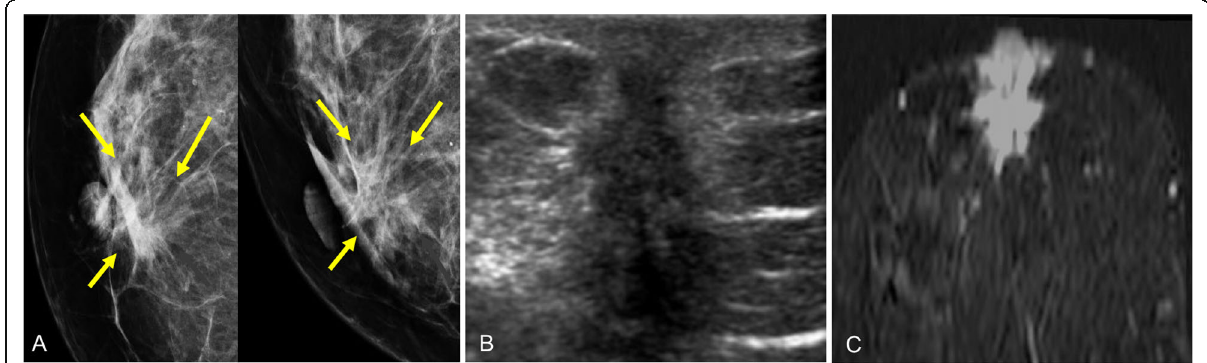
Fig. 32 Paget ’ s disease (I). A 56-year-old woman with right nipple retraction. a 2D mammogram shows a spiculated retroareolar mass in the right breast with nipple retraction and skin thickening; b on ultrasound, it is seen as a solid lesion with ill-defined borders. c MRI shows the retroareolar lesion extending to the nipple-areolar complex. Histologic study revealed infiltrating ductal carcinoma extending to the